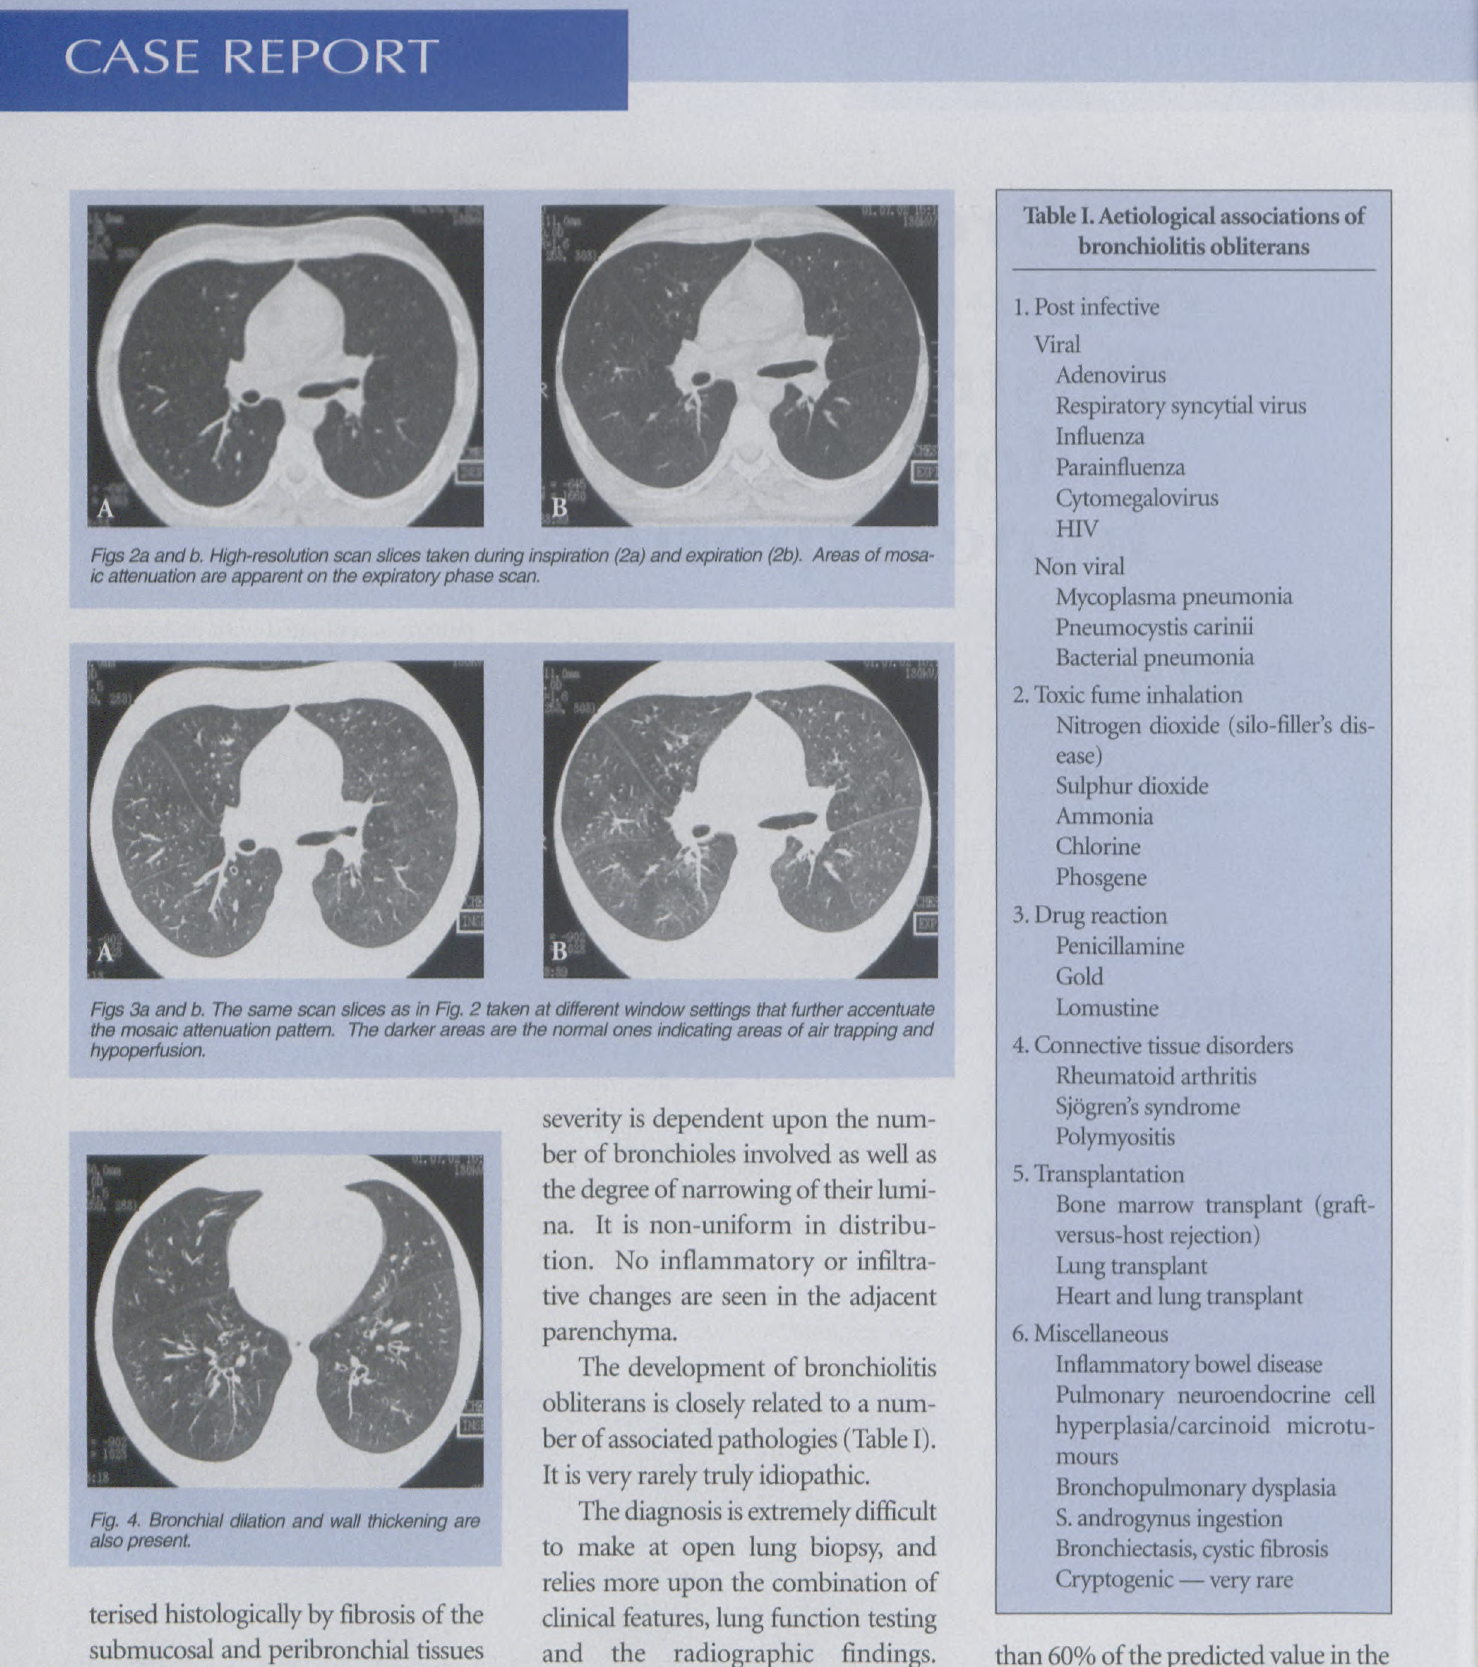
Fig. 4. Bronch/al dl/ation and wall thickening are also present.